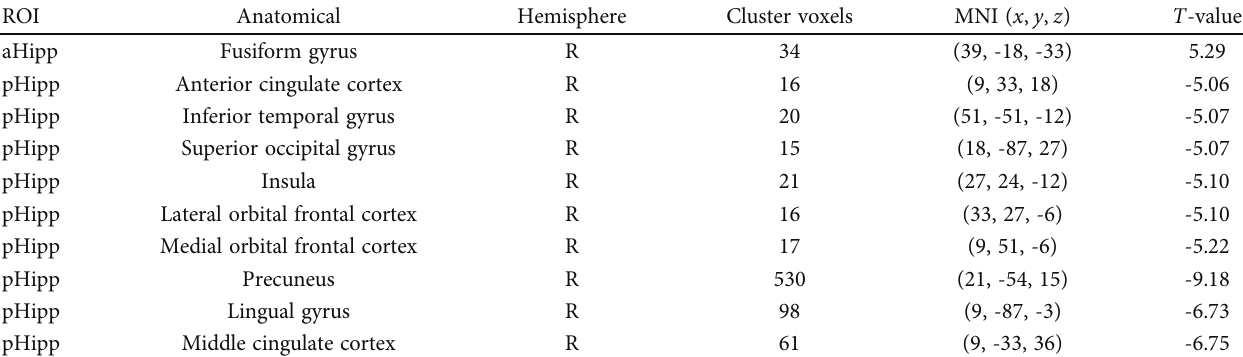
Table 2: The fi nal signi fi cant FC regions of aHipp.R and pHipp.R within the right